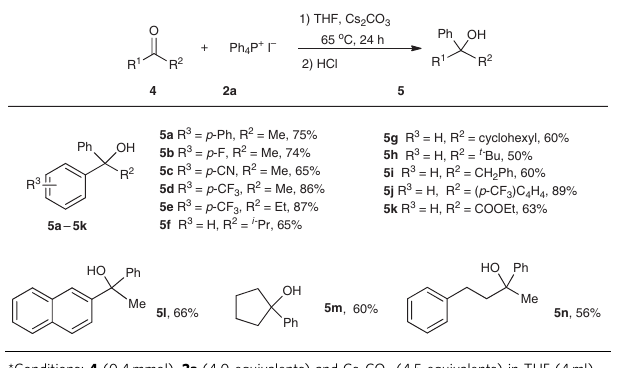
Table 2 | Substrate scope of phenylation of aldehydes*. Table 3 | Substrate scope of phenylation of